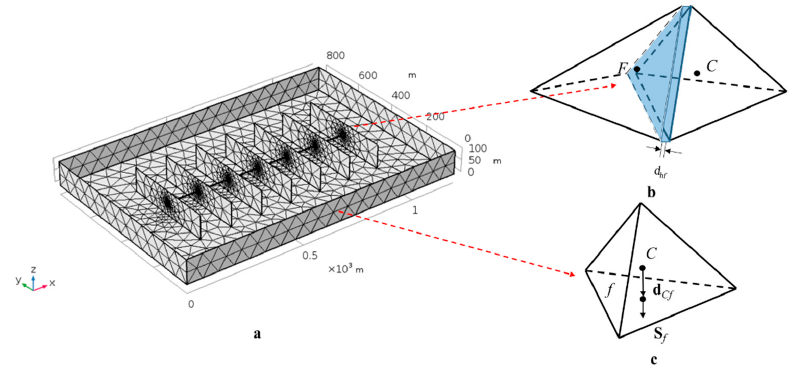
Figure 1. Diagram of a mathematical model. ( a ) Multi-section fractured horizontal well grid section diagram; ( b ) artificial fracture diagram; ( c ) grid of natural micro-fractures and matrix.